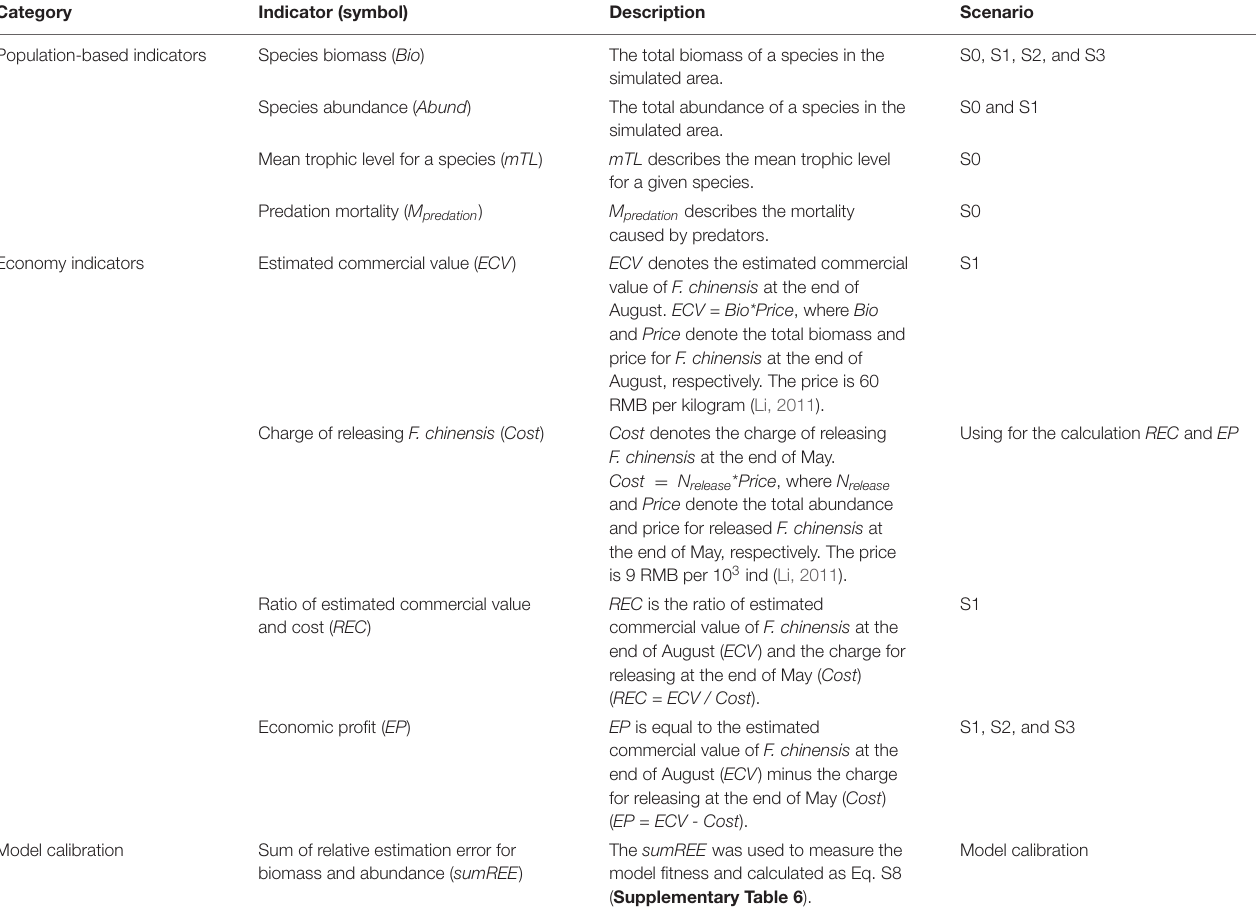
TABLE 2 | Definitions of indicators in the scenarios S0 to S3, model performance evaluation, and model